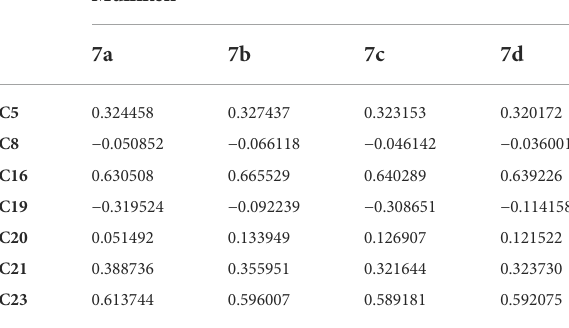
TABLE 5 Mulliken atomic charges.